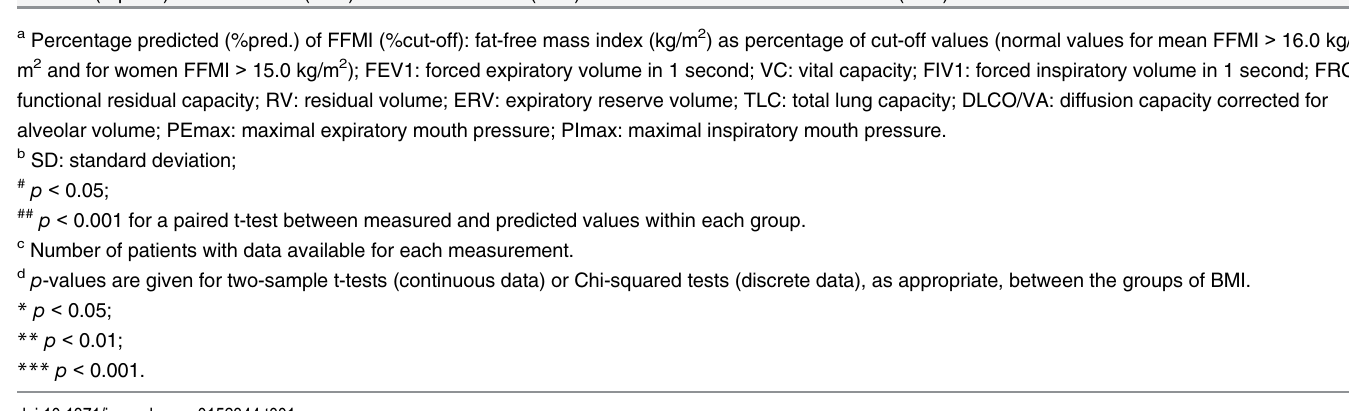
PLOS ONE | DOI:10.1371/journal.pone.0152344 March 25,